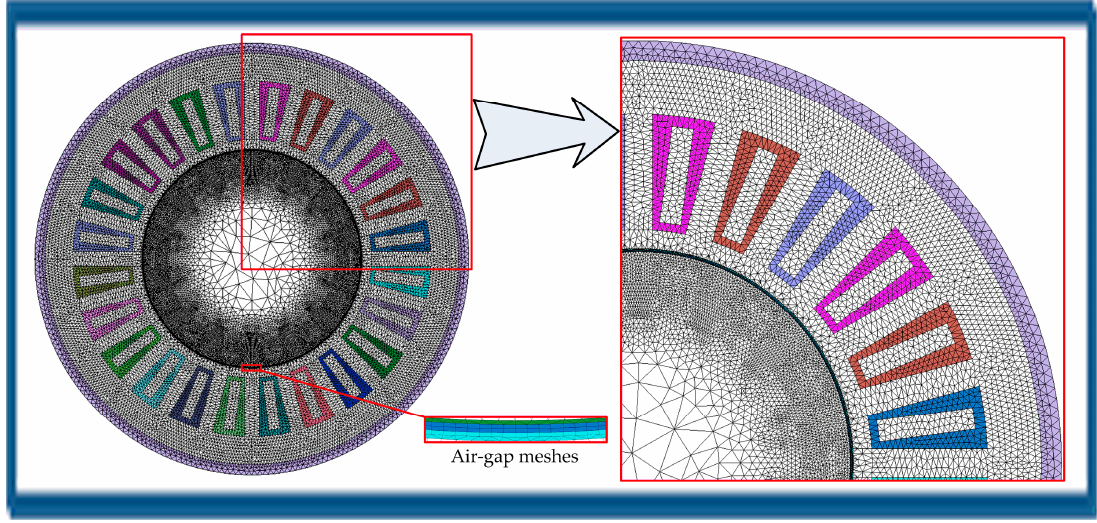
Figure 4. Mesh model of the proposed machine.